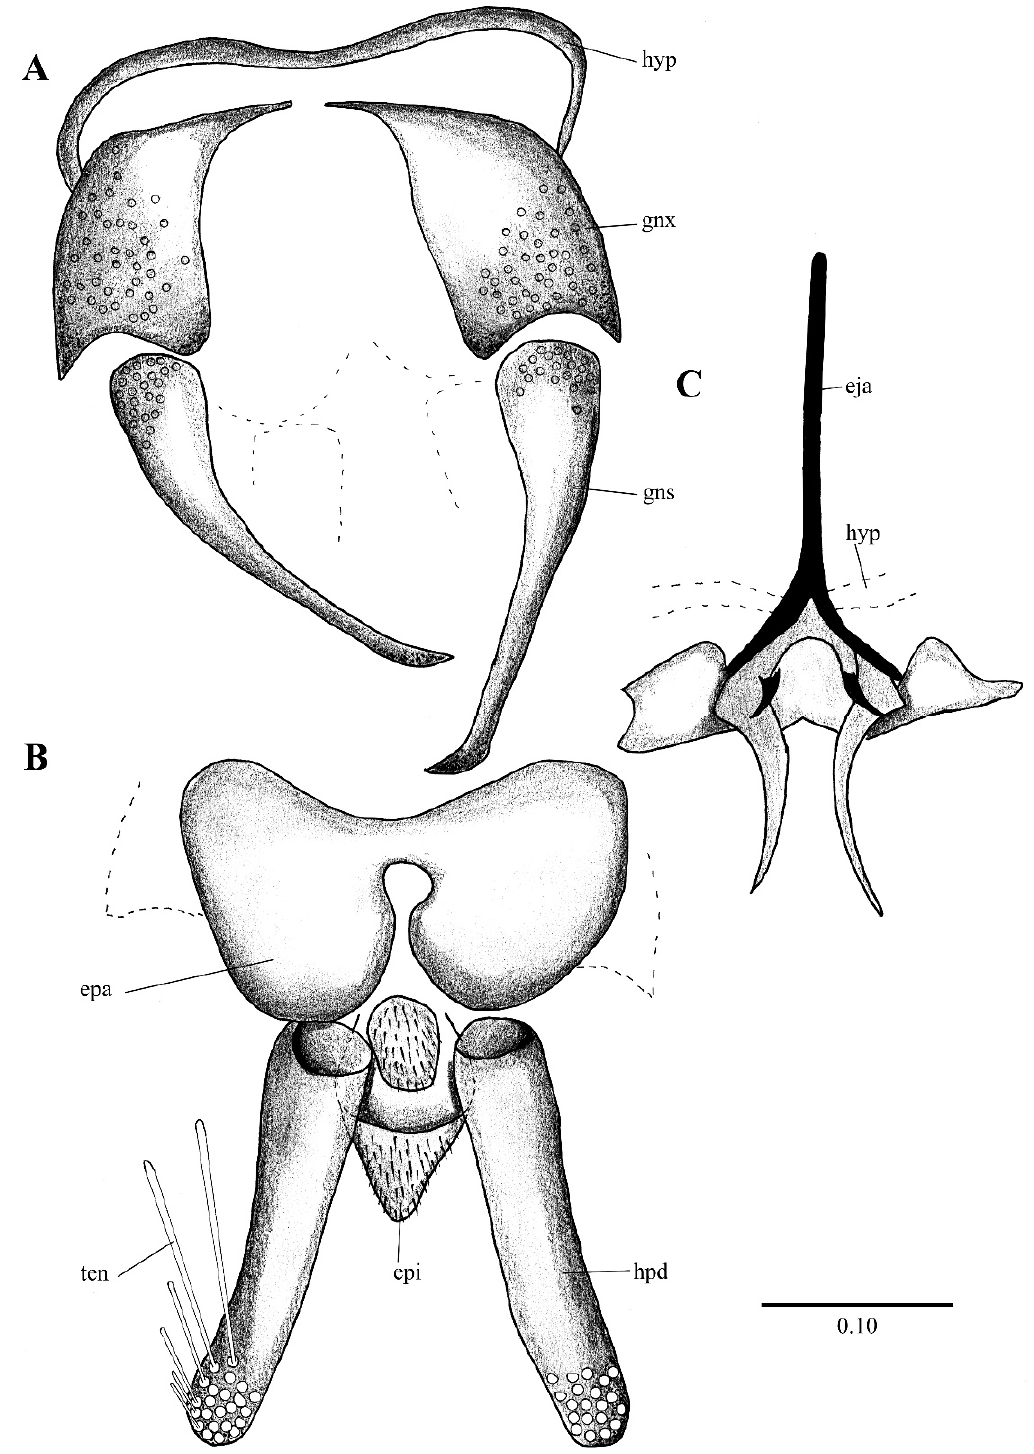
Figure 13. Telmatoscopus bartai (Ježek, 2004), male genitalia. ( A ) Hypandrium, gonocoxites and gonostylus. ( B ) Epandrium, hypopods, tenacula, hypoproct. ( C ) Aedeagus. Abbreviations: aed = aedeagus, epa = epandrium, epi = epiproct, eja = ejaculatory apodeme, gnx = gonocoxites, hpd = hypopod, hyp = hypandrium, ten = tenacula. Scale ( A – C ) in millimeters (mm). Species present in Europe associated with dendrotelmata : C. albipunctata (Williston, 1893) [35,36] (Table